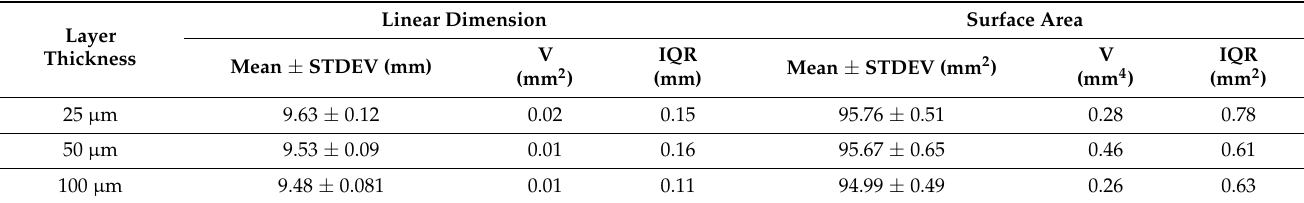
Intergroup comparisons: At printing time 0, there was a statistically significant dif- ference noted in the linear dimensions (0.15 mm) and surface area (0.77 mm 2 ), specifically between the 25 µ m and 100 µ m groups. The dimensional means were distinctively smaller